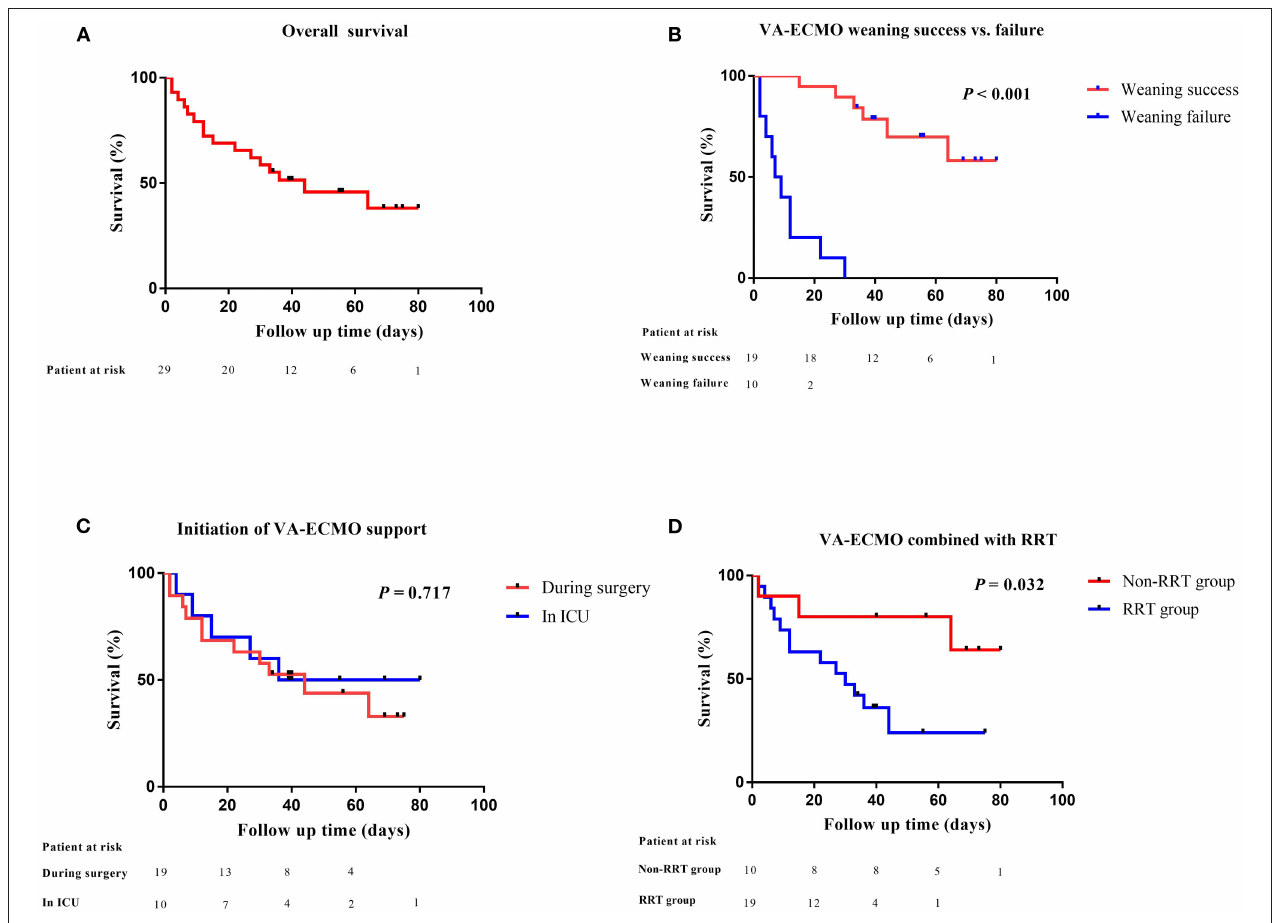
FIGURE 2 | Comparative survival in heart transplant patients after VA-ECMO support. (A) Kaplan–Meier analysis of overall survival in heart transplant patients supported by VA-ECMO from 2014 to 2020 ( n = 29); (B) VA-ECMO weaning success or failure; (C) initiation of VA-ECMO support; (D) VA-ECMO combined with RRT. VA-ECMO, veno-arterial extracorporeal membrane oxygenation; ICU, intensive care unit; RRT, renal replacement